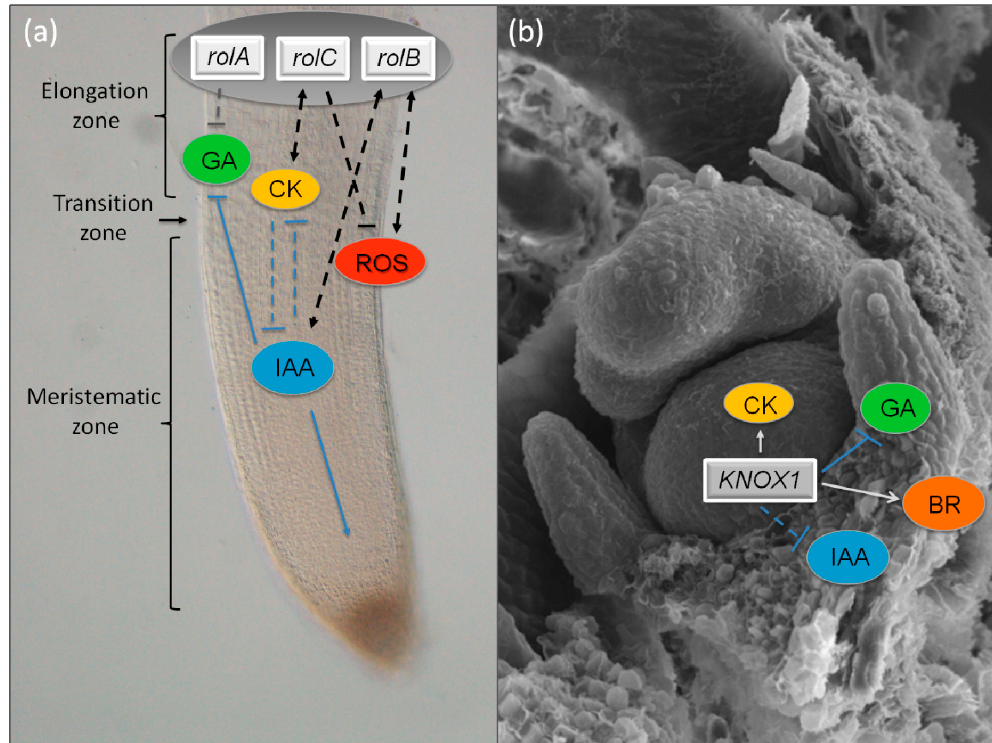
Figure 3. A simplified view of the involvement of A. rhizogenes rol genes and plant class 1 KNOX transcription factors in hormonal homeostasis in the root (left panel) or shoot (right panel) apical meristem. ( a ) rolA, rolB , and rolC may control hairy roots formation and their indefinite growth by hijacking some as-of-yet unknown components of the gibberellin (GA), auxin (IAA), and cytokinin (CK) metabolism, respectively; ( b ) class 1 KNOX control boundaries between undifferentiated cells and differentiating organs through the regulation of hormone metabolism and signaling. KNOX expression in the shoot apical meristem establishes a regime of high CK, low GA, and a gradient of auxin and brassinosteroids (BR) to keep the indeterminacy of the SAM and setting boundaries for proper organ separation during plant development.